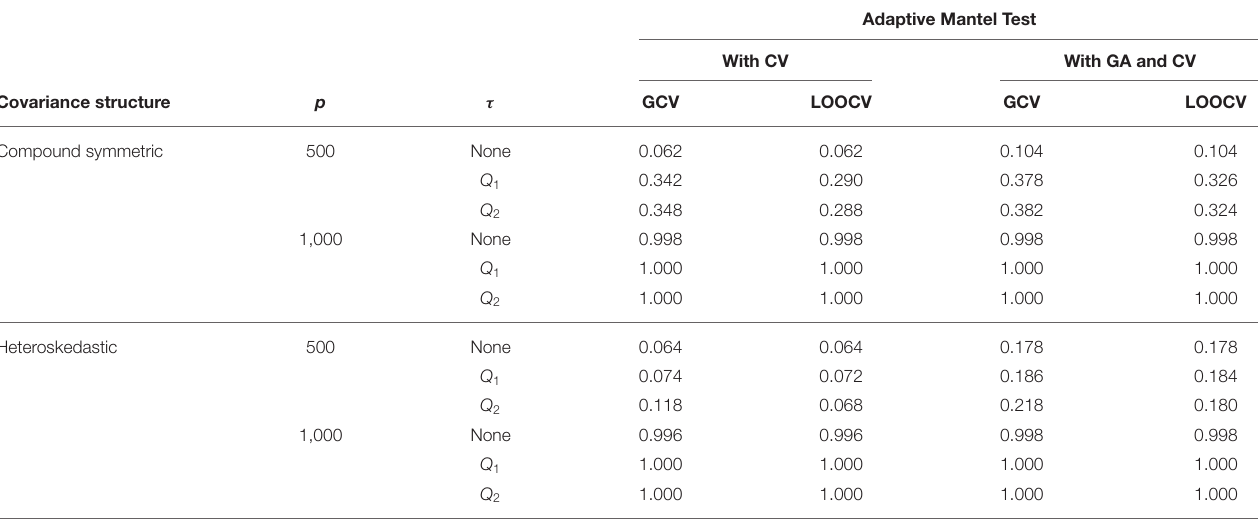
TABLE 2 | Numerical comparison of the Empirical Power of Adaptive Mantel test (i) with cross-validation vs. (ii) with Gamma approximation and cross-validation using the simulated data with n = 350, error standard deviation σ = 1 and β = ξ 1 p , ξ = 3.